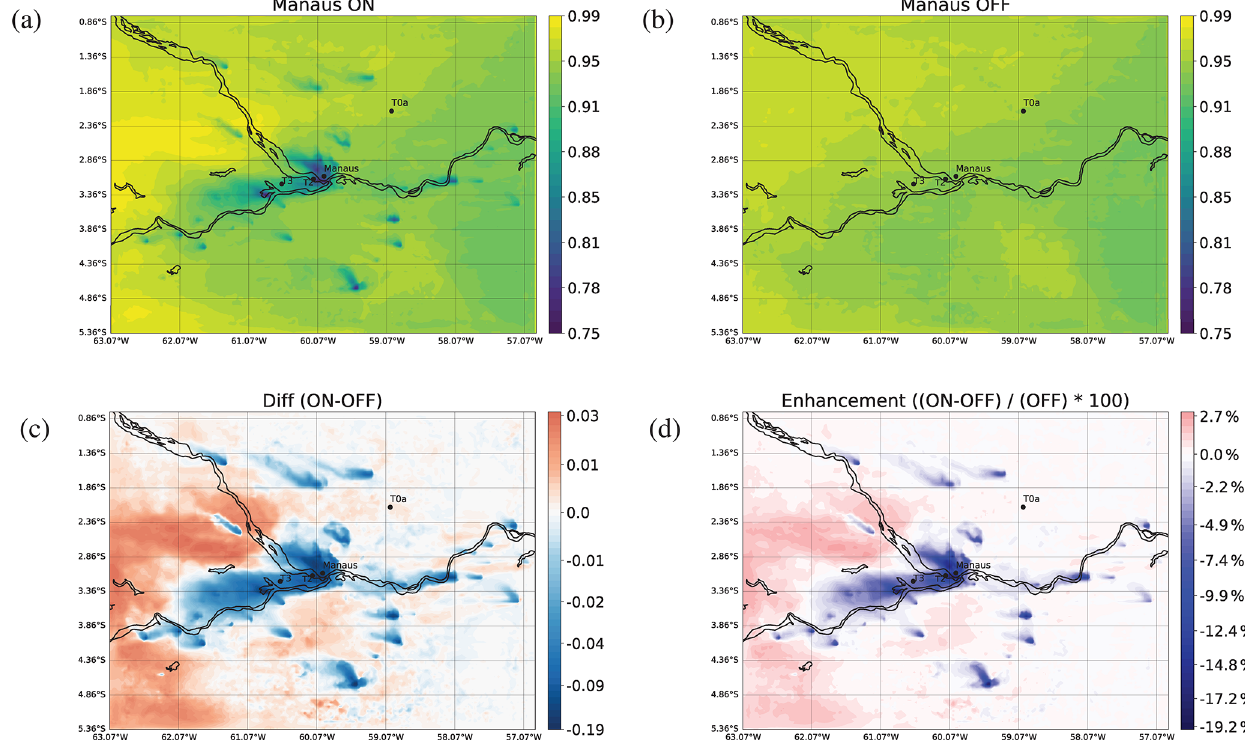
Figure 7. WRF-Chem simulated values of single scattering albedo (SSA) in the presence or absence of Manaus emissions. (a) SSA, when all emissions are on. (b) SSA, when just biogenic emissions are on and anthropogenic emissions are off. (c) SSA difference between the two simulations, with anthropogenic emissions turned on and off, i.e., (on − off). (d) SSA enhancement (in percent) calculated from the two simulations, with anthropogenic emissions turned on or off, i.e., ((on − off) / off) × 100. WRF-Chem predictions are at ca. 8m altitude, averaged over 13 March 2014